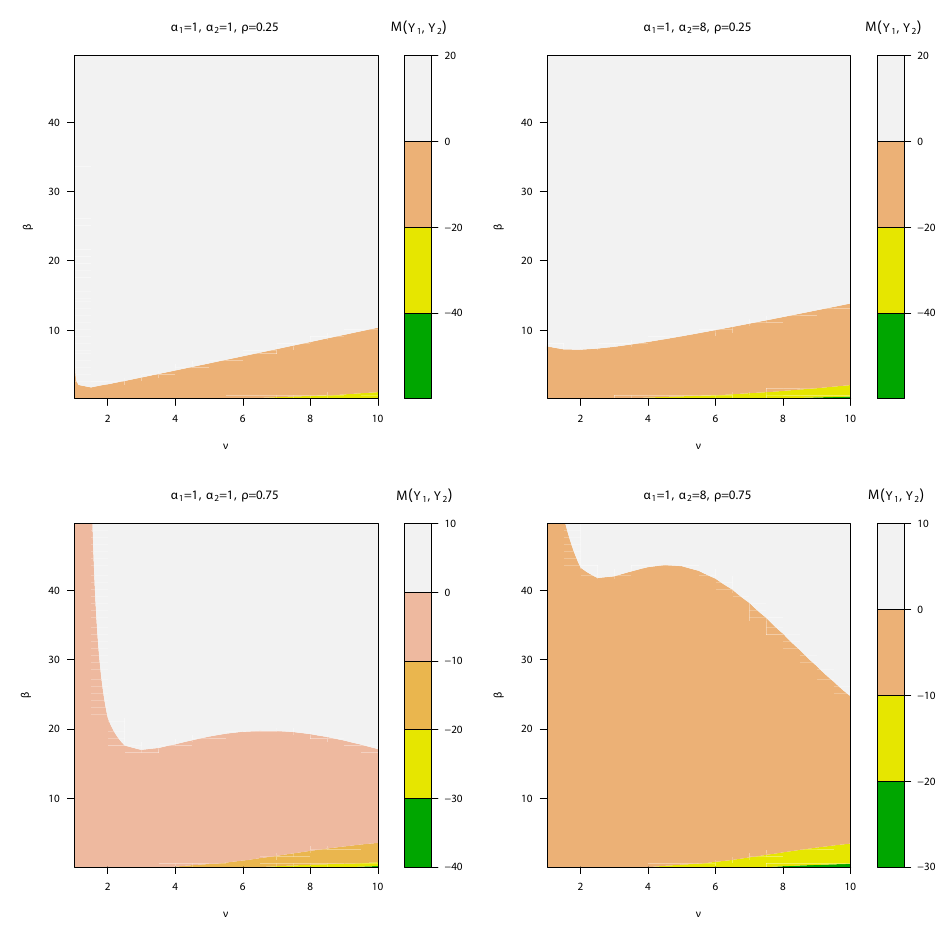
Figure 3. Mutual information index for several parameters of density given in